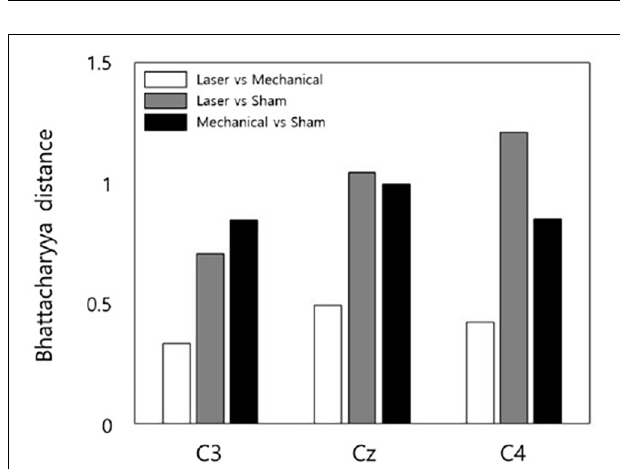
FIGURE 6 | The accuracy of decoding stimulation information from EEG data for each stimulus pair and each channel. The decoding model performed binary classification by classifying EEG data into one of the two stimuli in a pair.